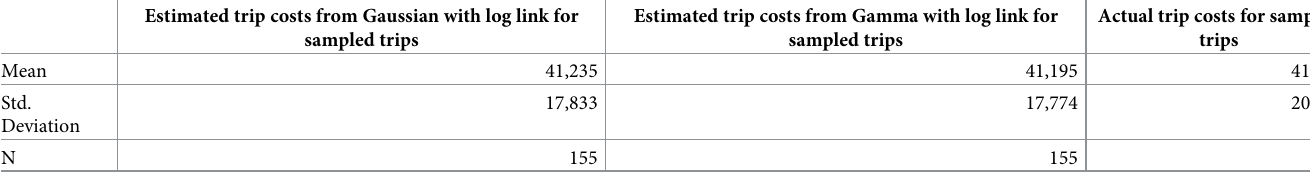
Table 9. Estimated and actual trip costs for sampled trips in American Samoa longline fishery. Estimated trip costs from Gaussian with log link for Estimated trip costs from Gamma with log link for sampled trips sampled trips